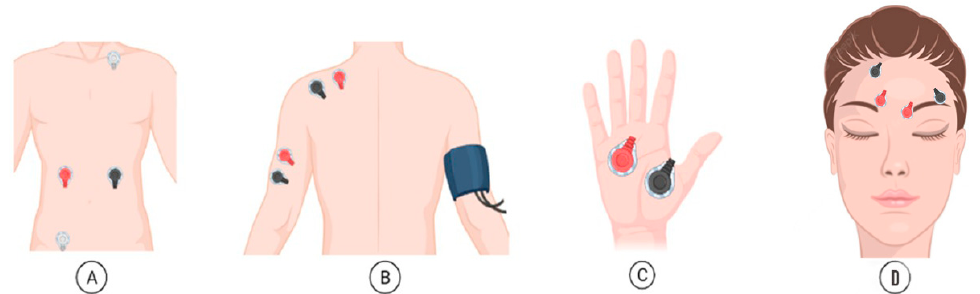
Figure 3. Placement of the electrodes to collect data: ( A ) ECG, ( B ) EMG in trapezius and triceps, ( C ) EDA, ( D ) EMG in corrugator and frontalis.